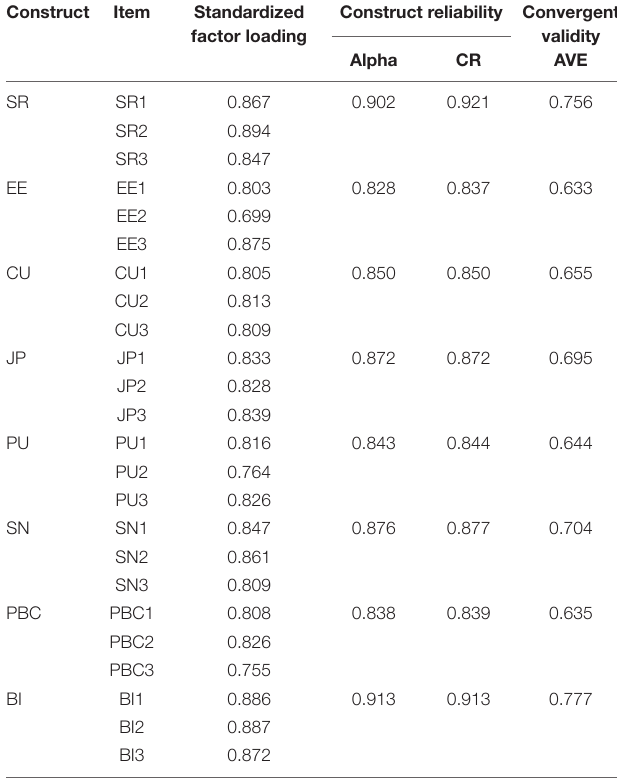
TABLE 1 | Results of the measurement model.